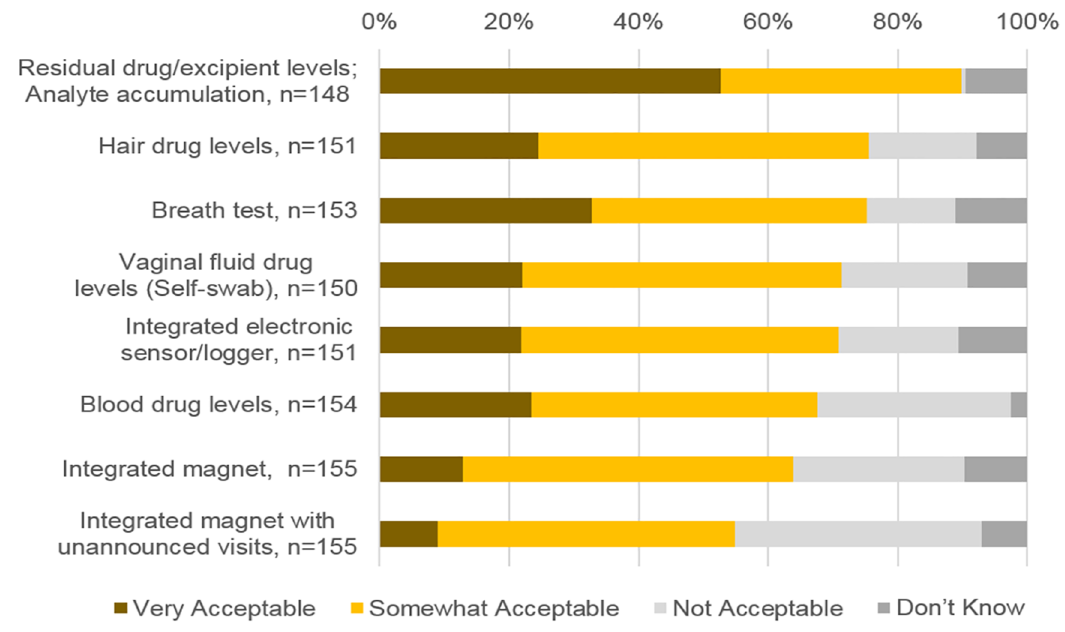
Fig 1. Respondents’ views on acceptability of measuresfor trial